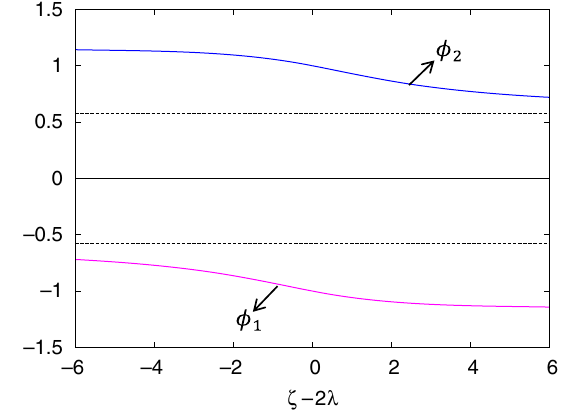
FIG. 2. The binodals ϕ 1 and ϕ 2 (coexisting densities for a flat interface) for K ¼ 1 and any value of A in the mean-field limit ( D ¼ 0 ). The binodals depend on a combination of the two activity parameters ( ζ − 2 λ ) and not on them separately. Dashed lines indicate spinodal density defined by f 00 ð ϕ